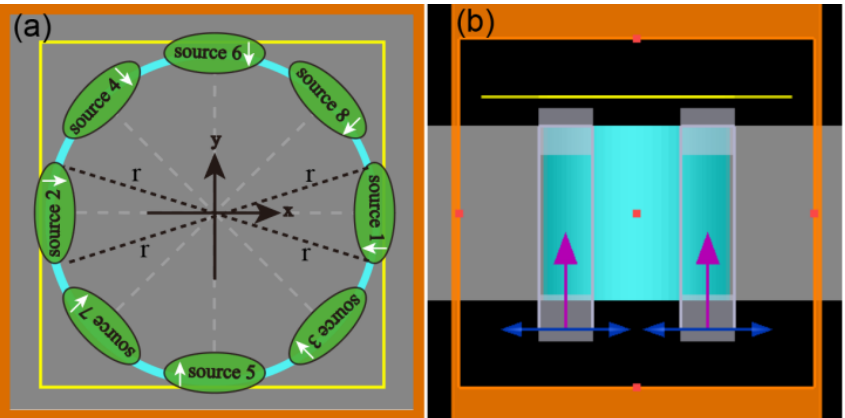
Figure 1. Schematic diagram of annular slit excited by multiple sets of symmetric linearly polarized beams. ( a ) Top and ( b ) side views. The polarization directions of the incident beams are indicated by blue arrows, the yellow frame indicates the monitor, and the annular slit is indicated by a blue line.